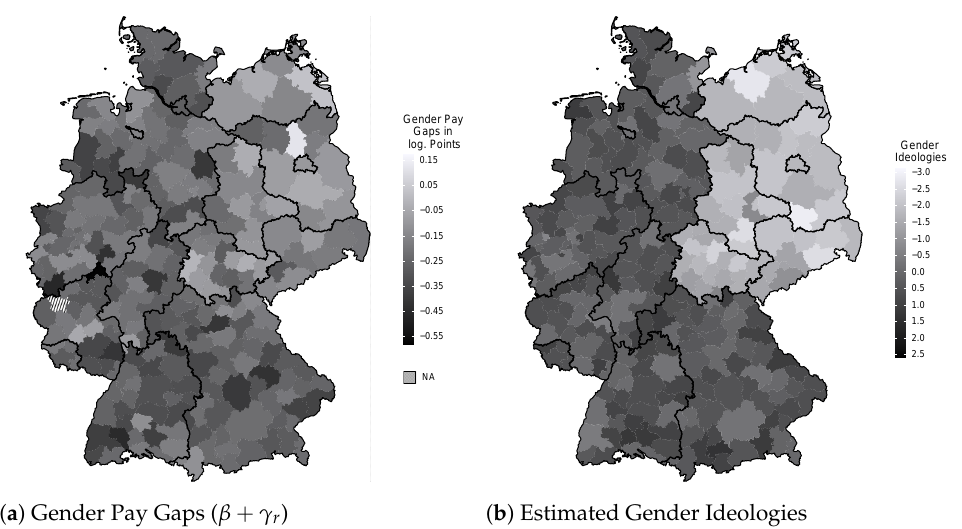
Figure 2. Region Level Gender Pay Gaps and Gender Ideologies. Source: SOEPv35; own estimation, regional pay gaps based on Model 1 of Table